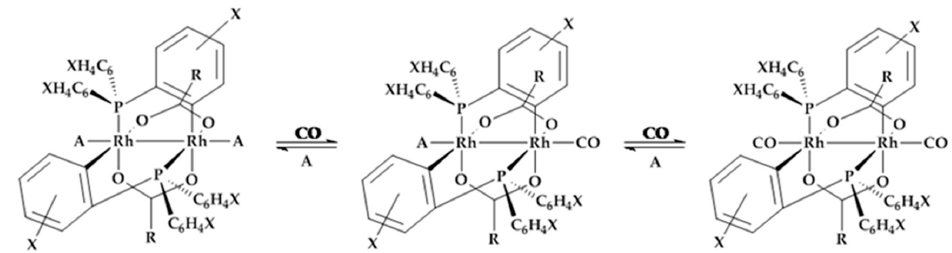
Figure 4. Principal reaction scheme of the rhodium complex with CO. The reaction induces a two stages ligand exchange of A with CO. Left: [Rh 2 {(XC 6 H 3 )P(XC 6 H 4 )} n (OCR) 2 ] ∙ (A) 2 , Middle: [Rh 2 {(XC 6 H 3 )P(XC 6 H 4 )} n (OCR) 2 ] ∙ (A,CO), Right: [Rh 2 {(XC 6 H 3 )P(XC 6 H 4 )} n (OCR) 2 ] ∙ (CO) 2